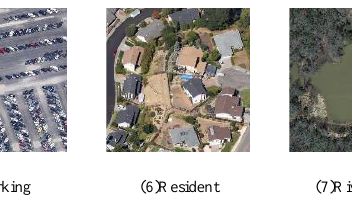
Figure 5. Some samples from the RSSCN7 dataset.